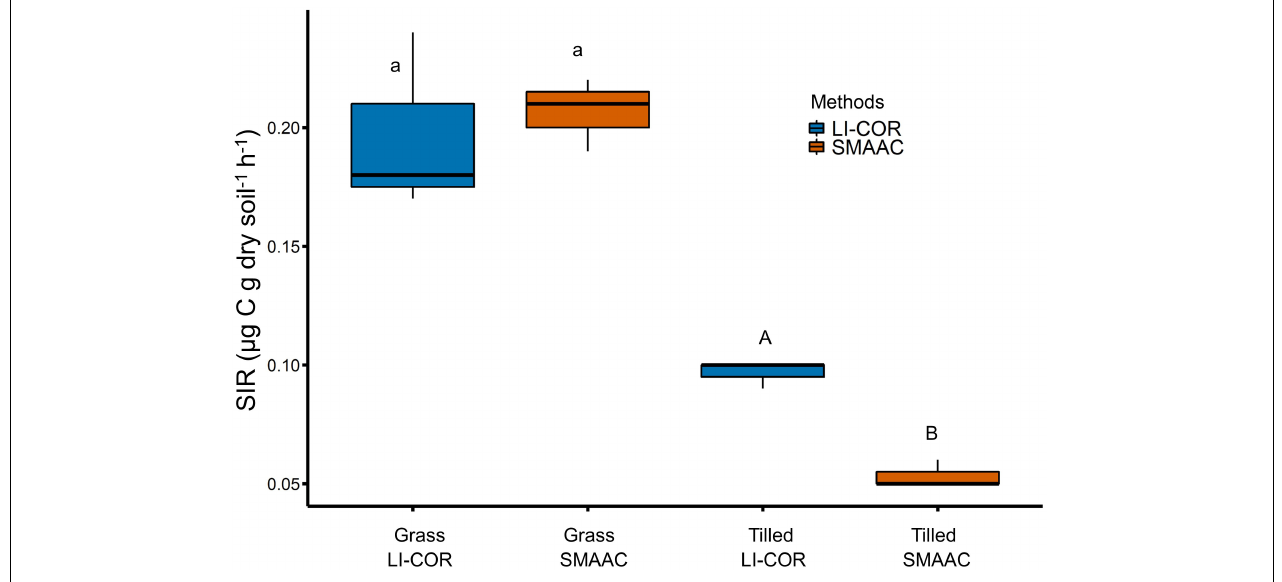
FIGURE 5 | Substrate induced respiration measured by a LI-COR 8100 (blue) vs. the SMAAC-Biomass configuration (orange). Different small letters indicate grass-covered soil fluxes are statistically different; different capital letters indicate tilled soil fluxes are statistically different (Students t -test; P <